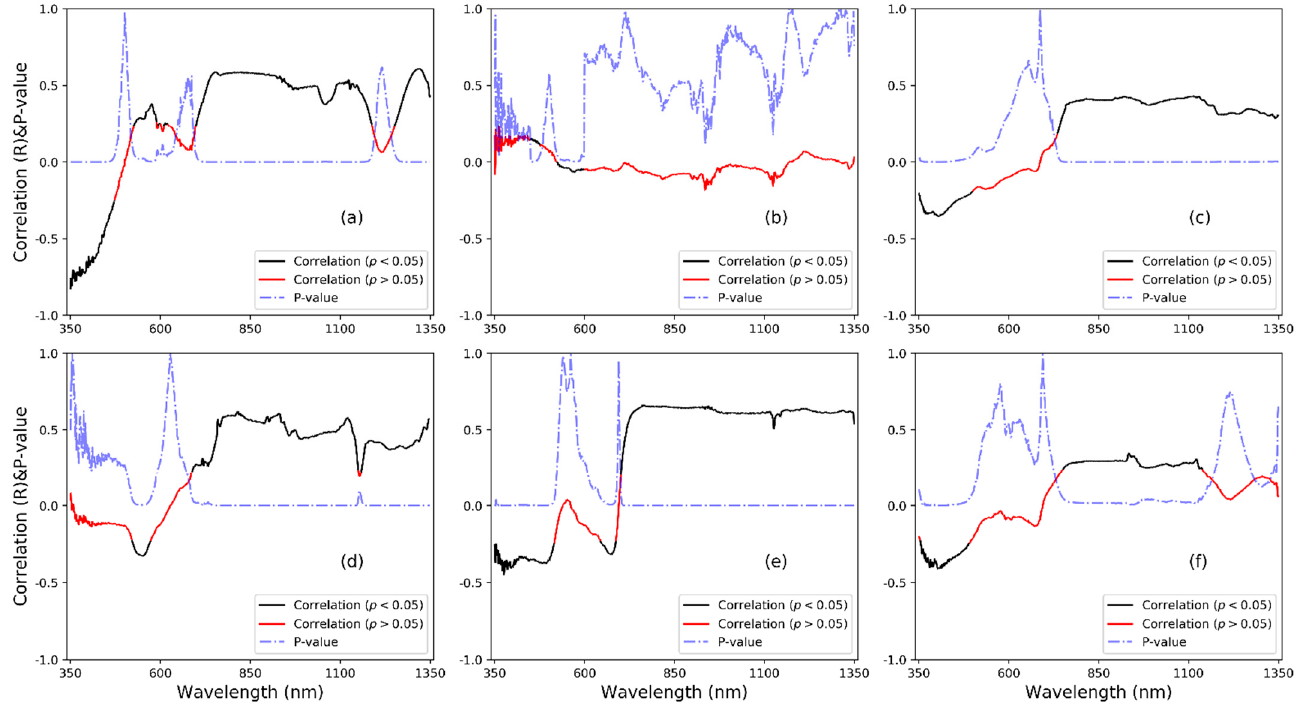
Figure 6. and T2 during 2016–2017: ( a – c ) are correlations of SPAD in DAH 14d, DAH 21d, and DAH 28d; ( d – f ) are corre- lations of LAI in DAH 14d, DAH 21d, and DAH 28d. The sample size for calculating Pearson ′ s correlation coefficient is